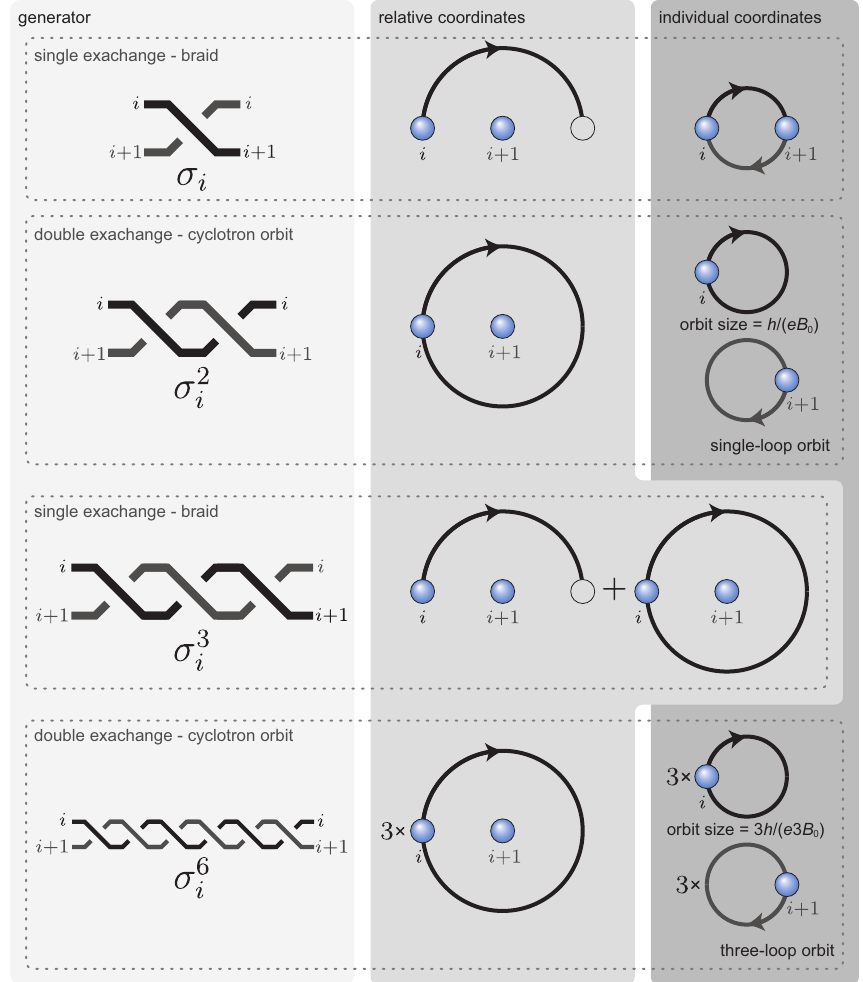
Figure 4. Schematic illustration that the elementary braids in the full group on the plane (the Artin group [34,35]), σ i , and in its cyclotron subgroups, σ q (in the figure for q = 3), must be half-pieces of i cyclotron orbits. The illustration is shown in individual coordinates of particle pairs on the plane and in relative coordinates, both for the generators—braids and for the cyclotron orbits—square of braids (cyclotron braids are half-pieces of cyclotron